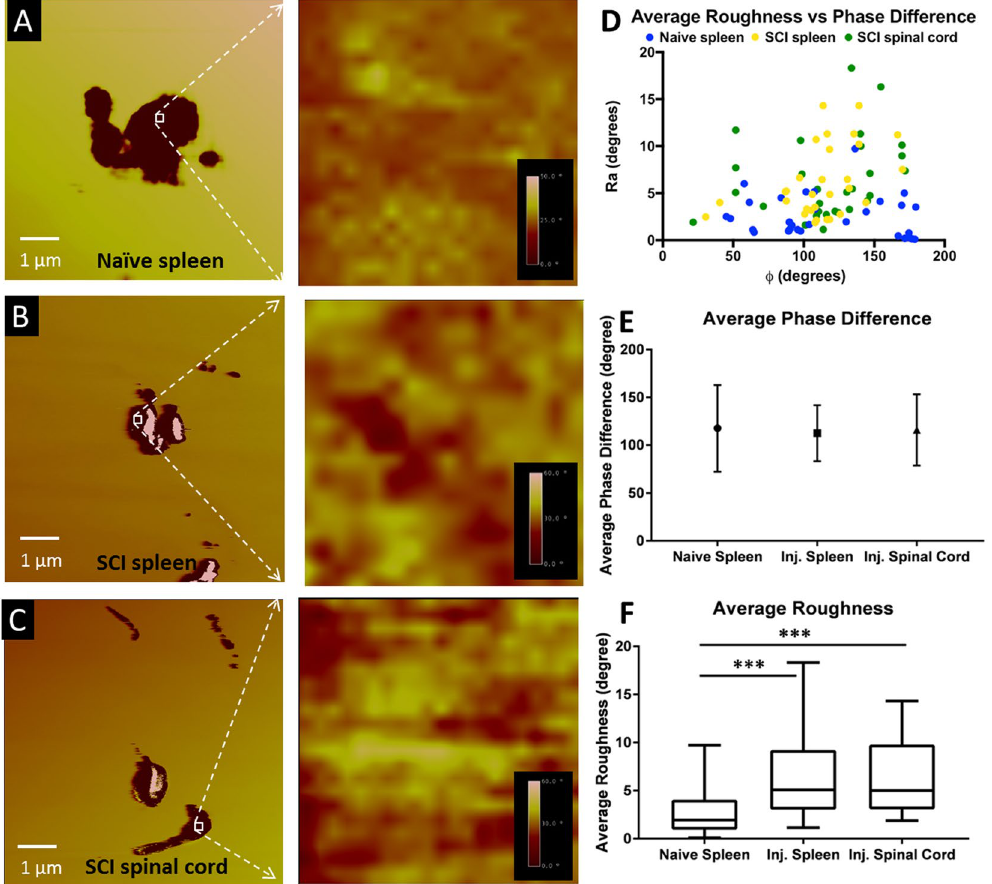
Figure 3. MFM phase images at a lift height, z = 30 nm for ( A ) naïve spleen, ( B ) spleen from SCI and ( C ) spinal cord from SCI rats. White square denotes the approximate location of a 0.04 μ m 2 ROI which was selected for roughness, R a, analysis, as shown alongside each phase image. (D-F) Quantitative analysis of MFM phase φ and roughness R a obtained from various regions in each sample type. ‘ *** ’ Indicates p-value <